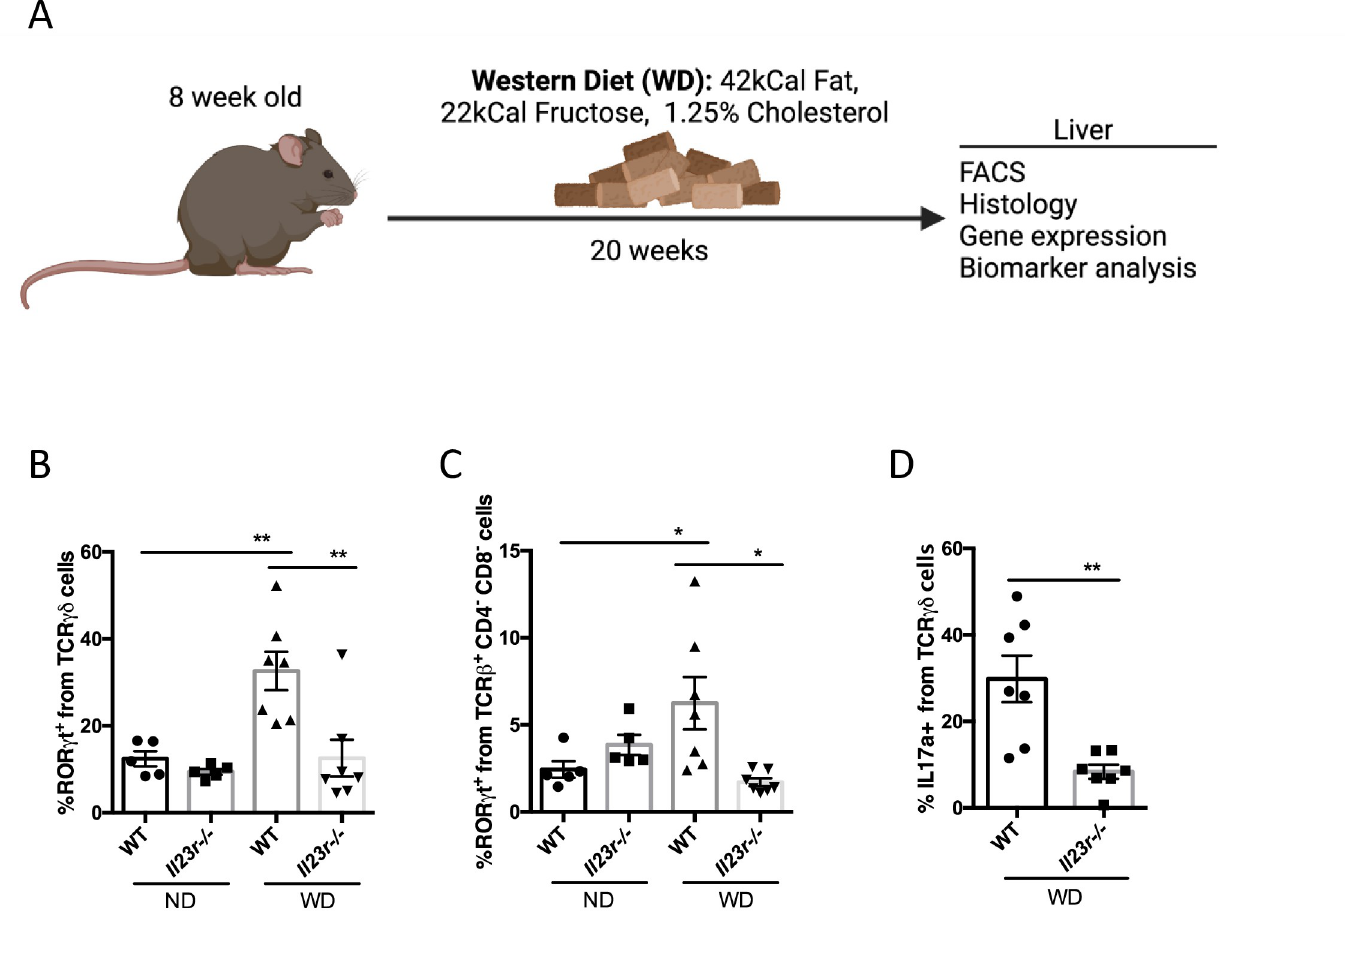
Fig 2. IL-23 is required for WD-induced hepatic IL-17 producing cell expansion. WT or Il23r -/- mice were fed a ND or WD for 20 weeks, followed by terminal analyses (A). FACS quantification of percent ROR γ t + from γδ T Cells and ROR γ t + from MAIT cells (CD3e + TCRb + CD4 - CD8 - ) (B-C). Percentage of IL-17A positive cells in γδ T cells from WD fed WT and Il23r -/- liver NPCs stimulated with leukocyte activation cocktail with GolgiPlug (BD) for 4 hours (D). Groups: ND WT n = 5, ND Il23r -/- n = 5, WD WT n = 7, WD Il23r -/- n = 7. Data represents mean ± S.D. � p < 0.05, �� p < 0.005, one-way